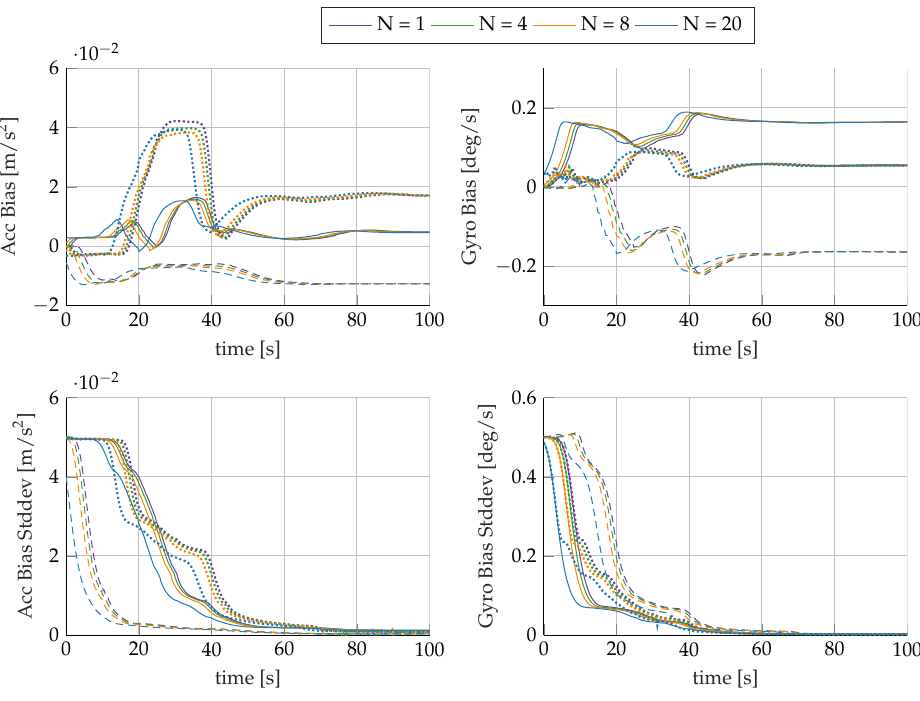
Figure 8. Time-lagged solution for bias values ( x , y , z ) of accelerometer and gyroscope and their corresponding standard deviations for different horizons N